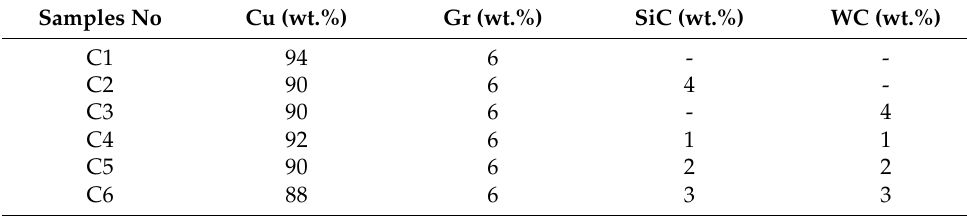
Table 2. The reinforcement ratios of composite